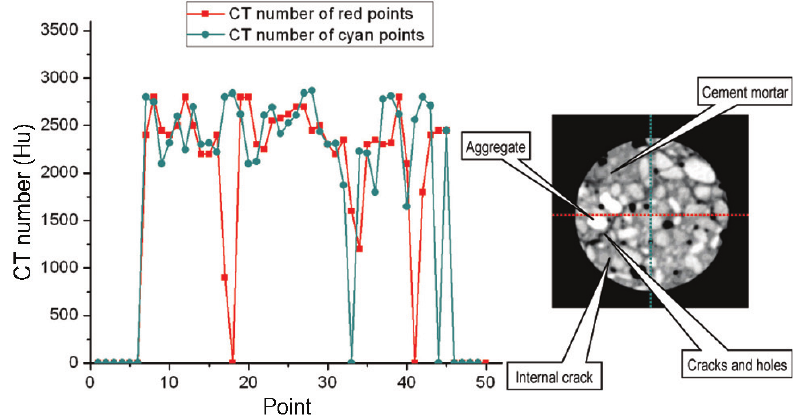
Fig. 1. Point-CT number curve and CT